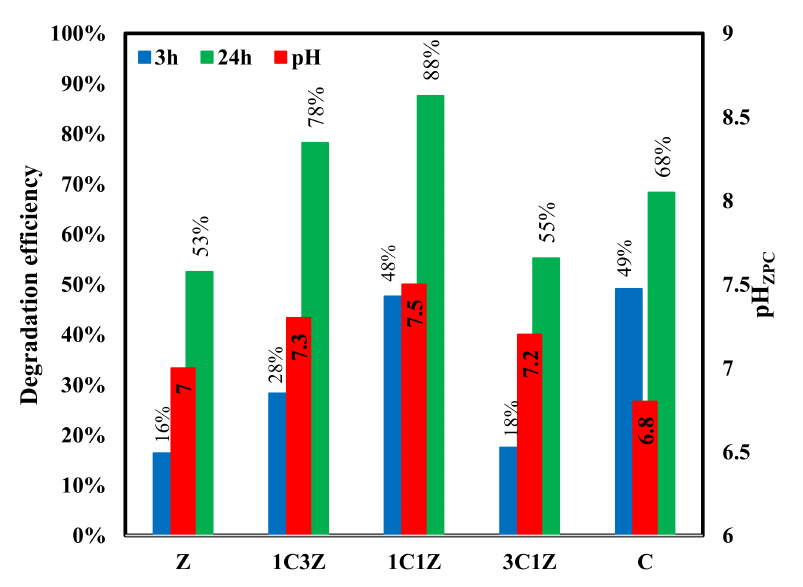
Figure 9. The removal percentage of MO after different intervals for Z, 1C3Z, 1C1Z, 3C1Z, and C greenly prepared via hydrothermal route (pH = 10, T = 250 ◦ C, t = 2.5 h) and calcination for 2 h at 300 ◦